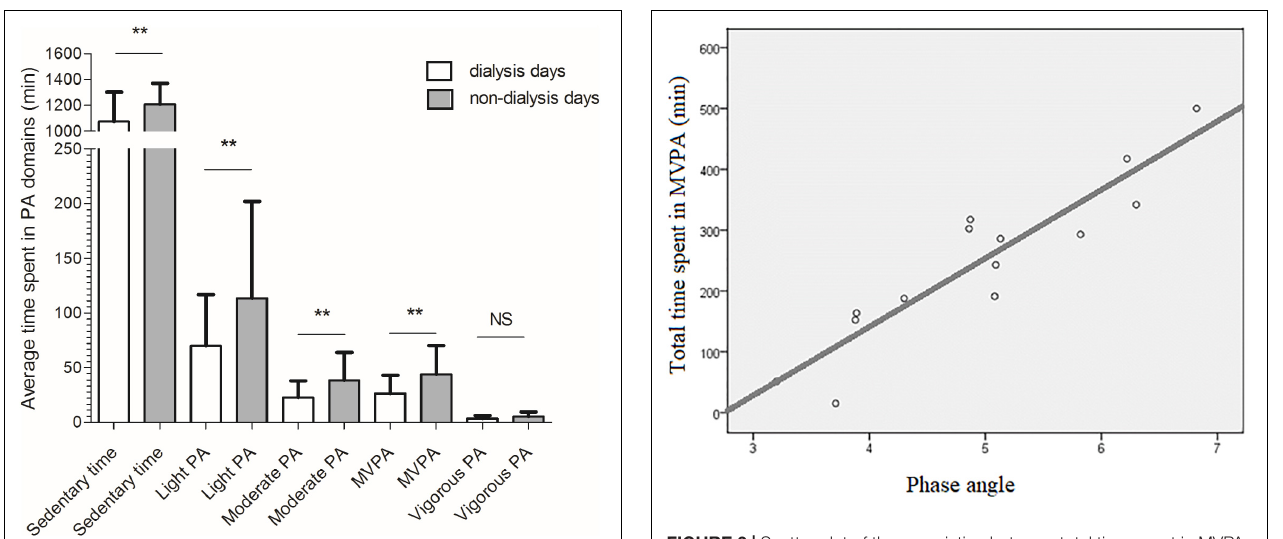
FIGURE 3 | Scatter plot of the association between total time spent in MVPA and phase angle. MVPA, moderate to vigorous physical activity; r, Pearson’s product-moment correlation coefficient = 0.919, p < 0.001; R2, coefficient of determination = 0.845, p <